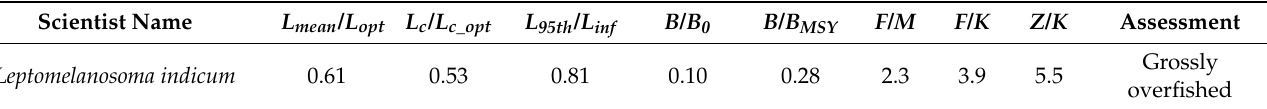
Figure 2. The graphical outputs of LBB for the Indian Salmon. Panel-( A ) displays the accumulated length frequency ( LF ) data analyzed for estimating the priors for L c, , Z/K and L inf , . Panel-( B ) shows the L opt, L inf and Z/K assessed by the fitting curve. Table 5. Estimated results from length–frequency data of L. indicum by the LBB method.